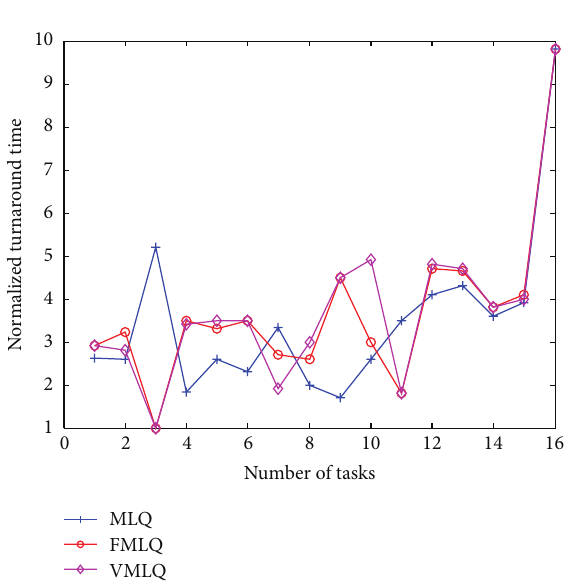
Figure 12: Turnaround time (sample task set).